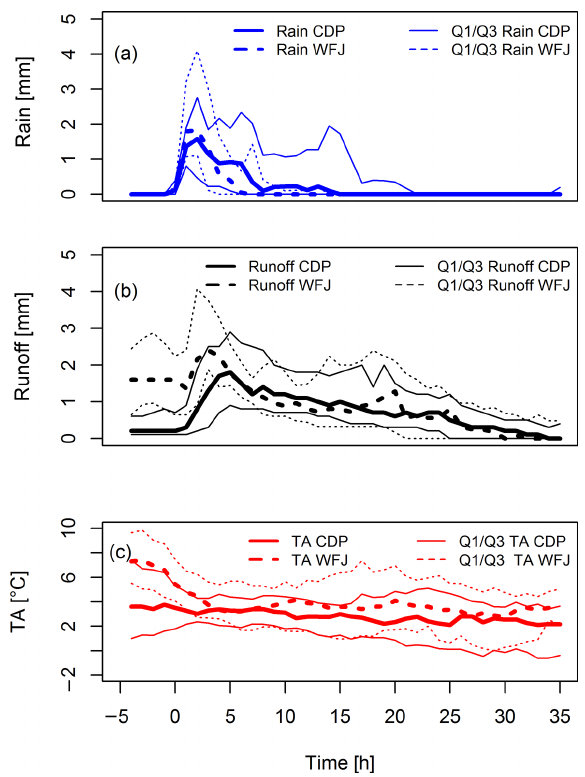
Figure 7. Temporal course of median rain (a) , measured snowpack runoff (b) and air temperature (c) for WFJ (dotted) and CDP (solid) aggregated over all 40 and 61 events respectively. The thinner lines represent the lower and upper quartiles, respectively. The displayed period is extended by 5h prior to event commencement according to the event definition